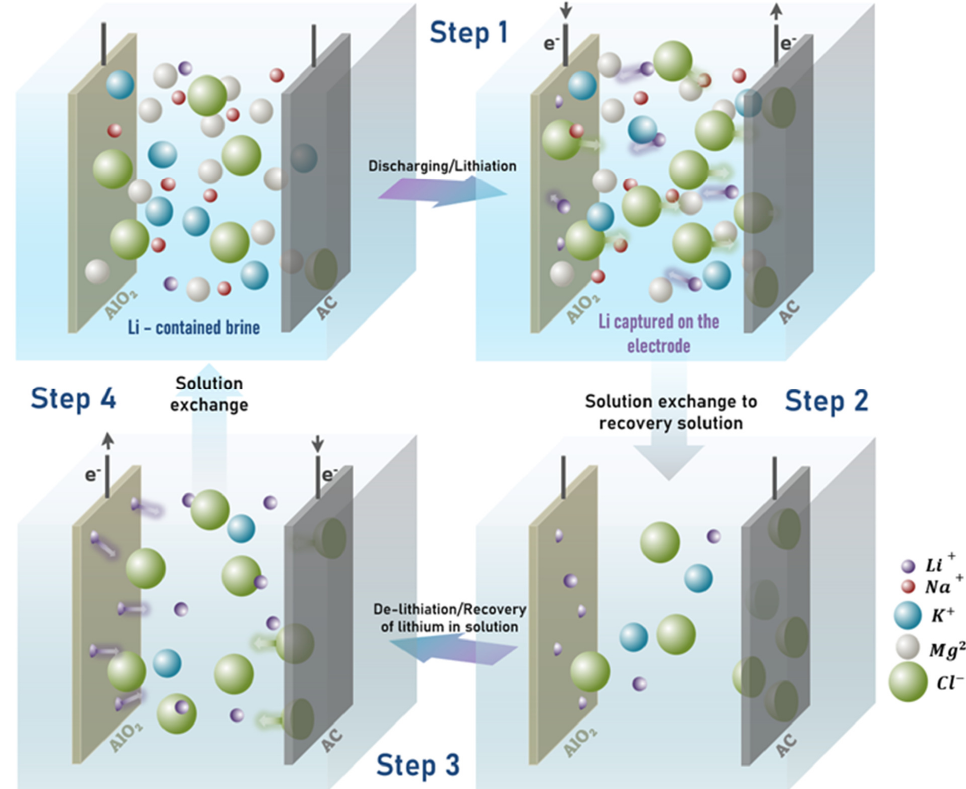
Figure 2. Schematic illustrating the four steps of the lithium recovery cycle from brines using LiAlO 2 (AlO 2 *) as Li + capturing electrode and activated carbon (AC) counter electrode. In the third step, a positive current is applied across the electrodes in the recovery solution. This is the lithium capture step, during which Li is released into the solution while anions adsorbed on the AC are returned to the solution. As Li + ions are released from the LiAlO 2 electrode, a Li-deficient LiAlO 2 electrode (technically AlO 2 *) is simulta- neously generated, making it ready for another Li capture cycle (Step 4). The cell config- uration resembles Step 1, with the difference being that the recovery solution has been replaced with a fresh batch of Li-rich source solution. Energy is consumed during the charging step to release Li ions from the LiAlO 2 material into the recovery solution.